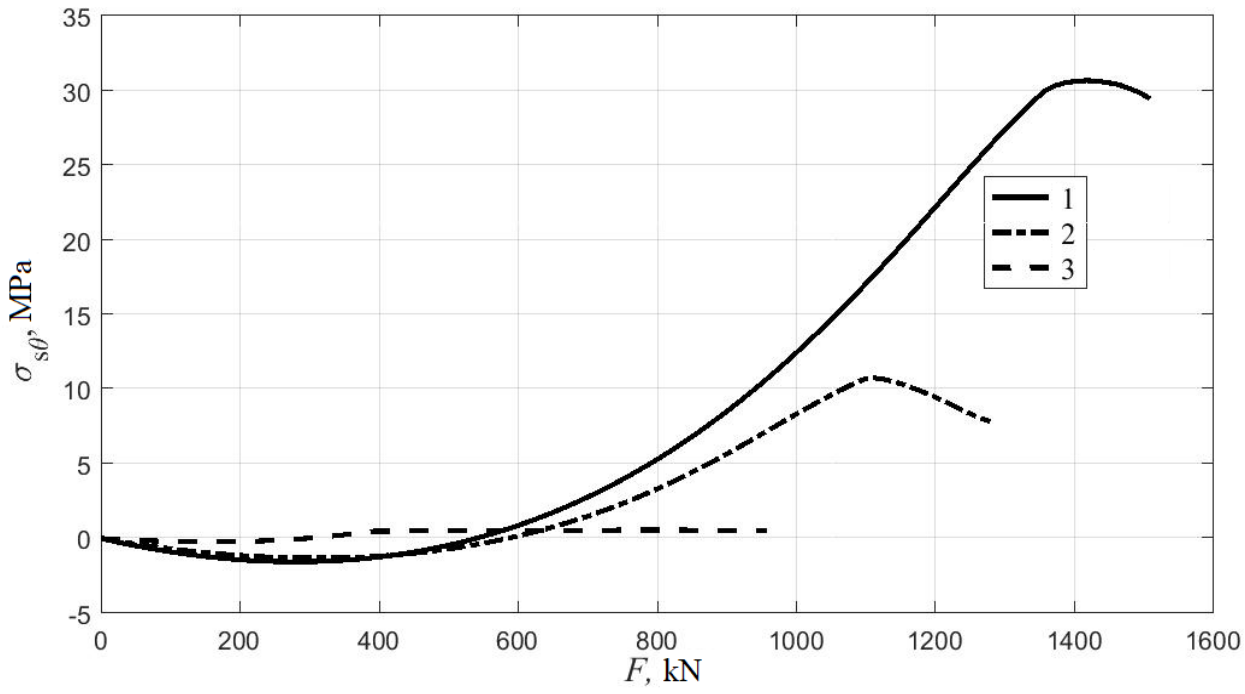
Figure 9. Dependence of stresses σ s θ at y = − R on load. From the presented graphs, it can be seen that—with an increase in eccentricity— the stresses σ s θ decrease, which also indicates a reduction in the stresses of the lateral compression of concrete. This explains the fact that the area of effective operation of CFST columns is small eccentricities of the longitudinal